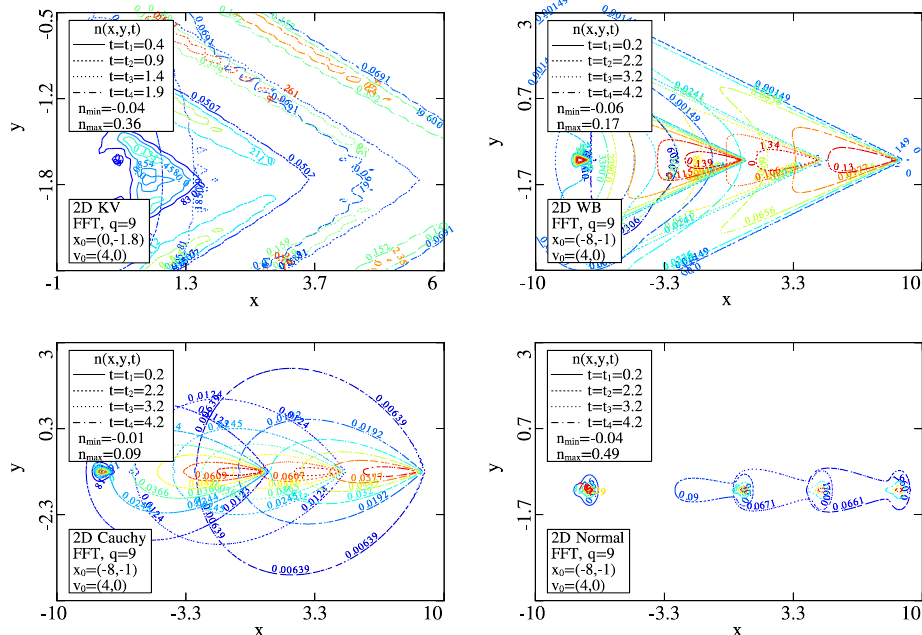
FIG. 4. The density n ð ~ x ; t Þ for the KV, WB, normal, and Cauchy distributions in 2D space.